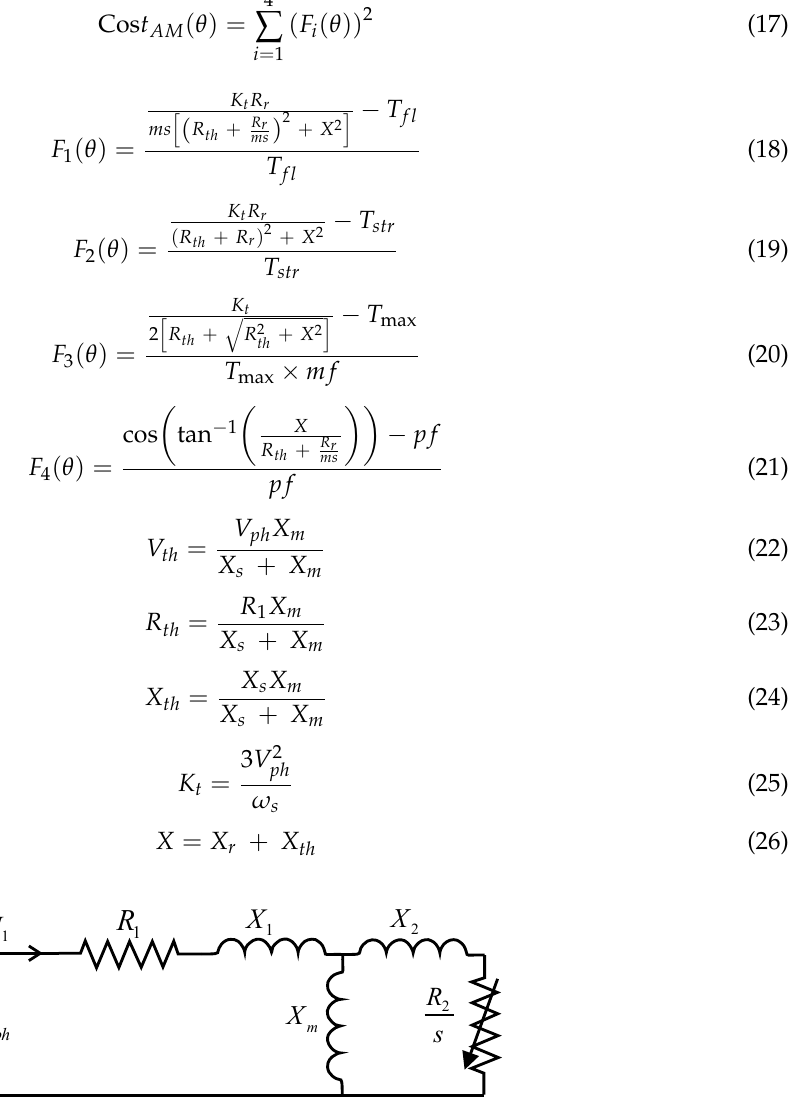
Figure 4. Simple radial distribution system. 5.2. Mathematical Approach The optimal allocation of capacitors in distribution network buses is represented by the solution that minimize the annual cost generated by power losses of the whole system (Equation 31), as well as the cost of capacitor installation (Equation 32):